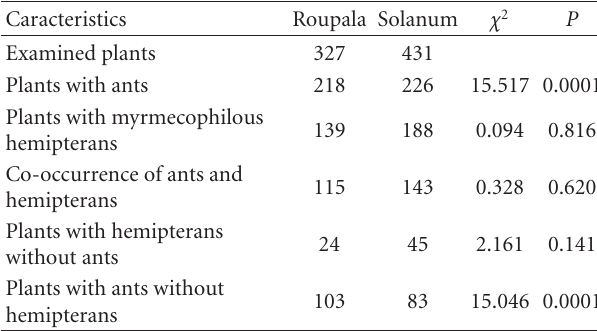
Table 1: Frequency of occurrence of ants and myrmecophilous hemipterans on Roupala montana (Proteaceae) and Solanum lyco- carpum (Solanaceae), in Fazenda Agua Limpa, Federal District, Brazil. Comparisons made with contingency